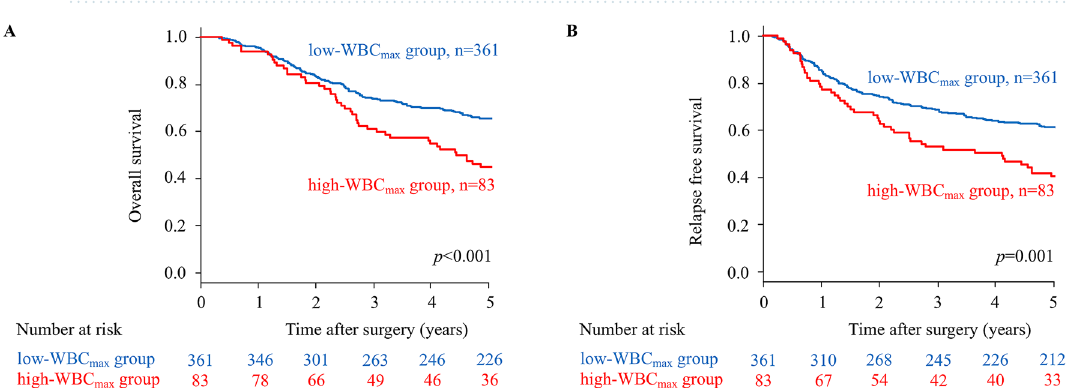
Figure 2. Kaplan–Meier survival curves of overall survival (OS) and relapse-free survival (RFS) according to WBC max in patients with stage II/III gastric cancer. ( A ) The five-year OS rates were 58.1% in the low-WBC max group and 37.4% in the high-WBC max group ( p < 0.001). ( B ) The five-year RFS rate were 56.1% in the low- WBC max group and 36.1% in the high-WBC max group ( p = 0.001).